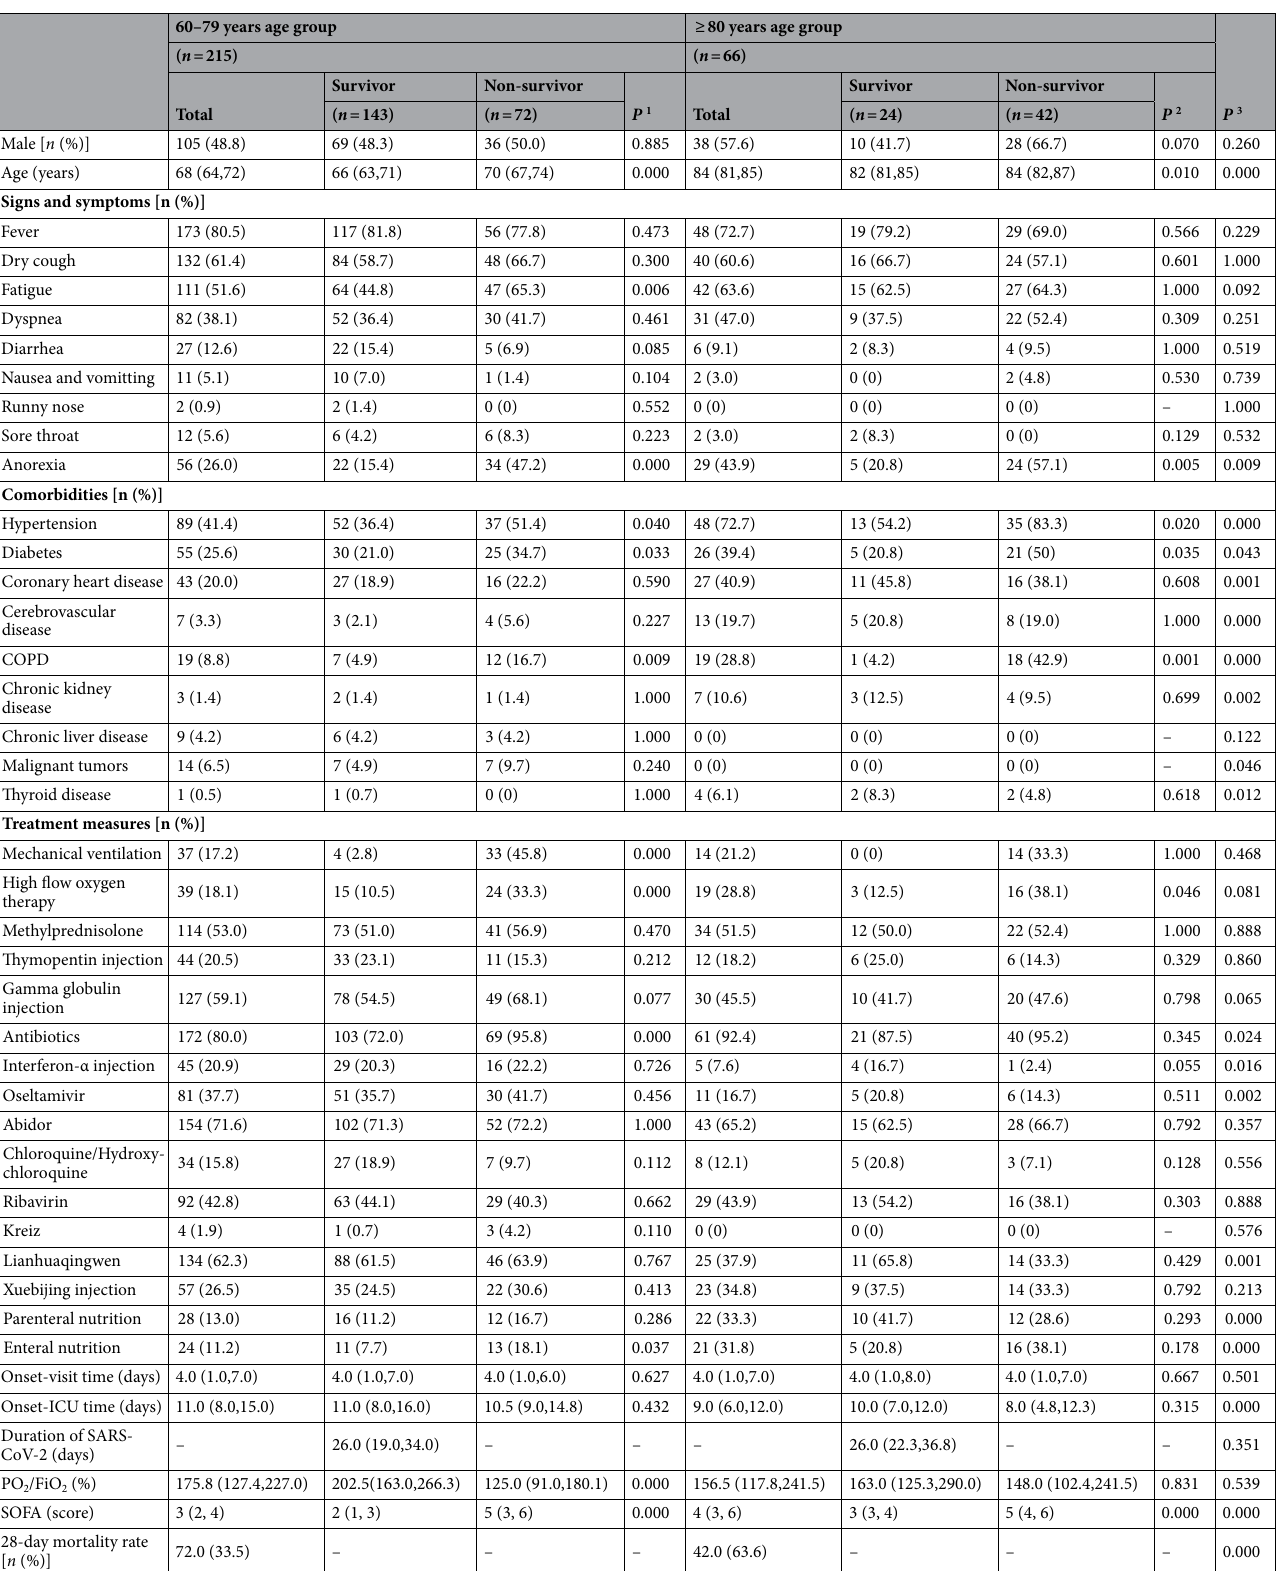
Table 1. Baseline and clinical characteristics of the study cohort. Values are medians (interquartile ranges). P 1 indicates the P -values for the comparison of survivors and non-survivors in the 60–79 years age group; P 2 indicates the P -values for the comparison of survivors and non-survivors in the ≥ 80 years age group; P 3 indicates the P -values for the comparison of the 60–79 years age group and the ≥ 80 years age group. COPD, chronic obstructive pulmonary disease; ICU, intensive care unit; SOFA, Sequential Organ Function